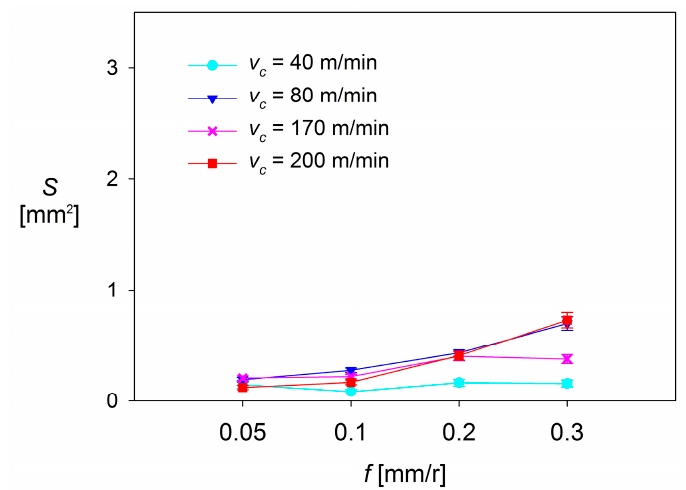
Figure 12. S = f( v c , f ), for a p = 0.5 mm.